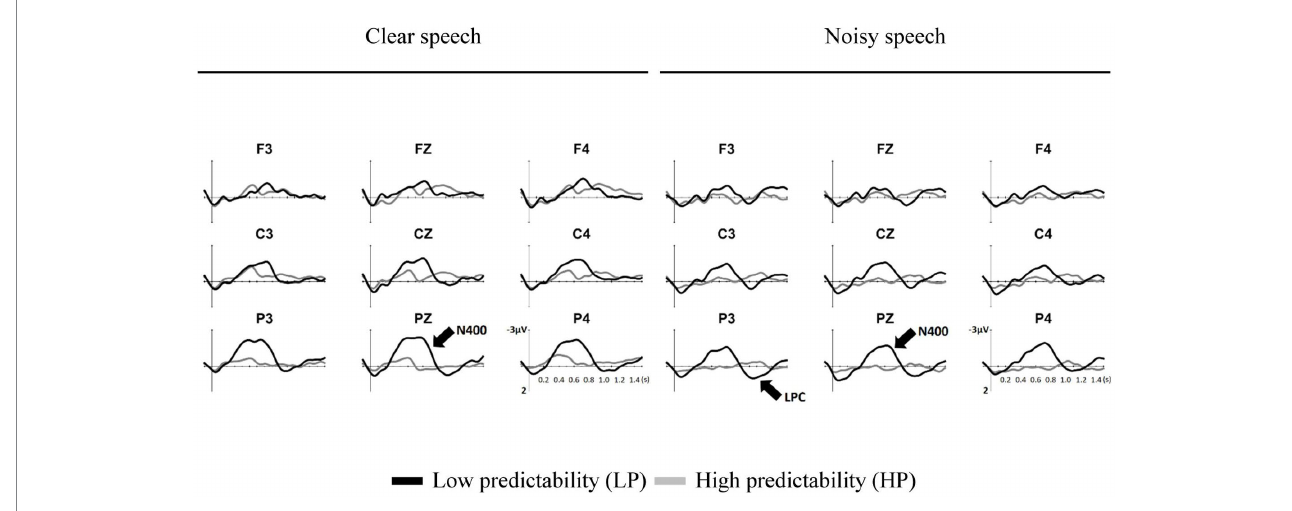
FIGURE 1 The averaged event-related modes (ERMs) of the low- (black line) and high- (grey line) predictability words in the clear condition (left) and the noisy condition